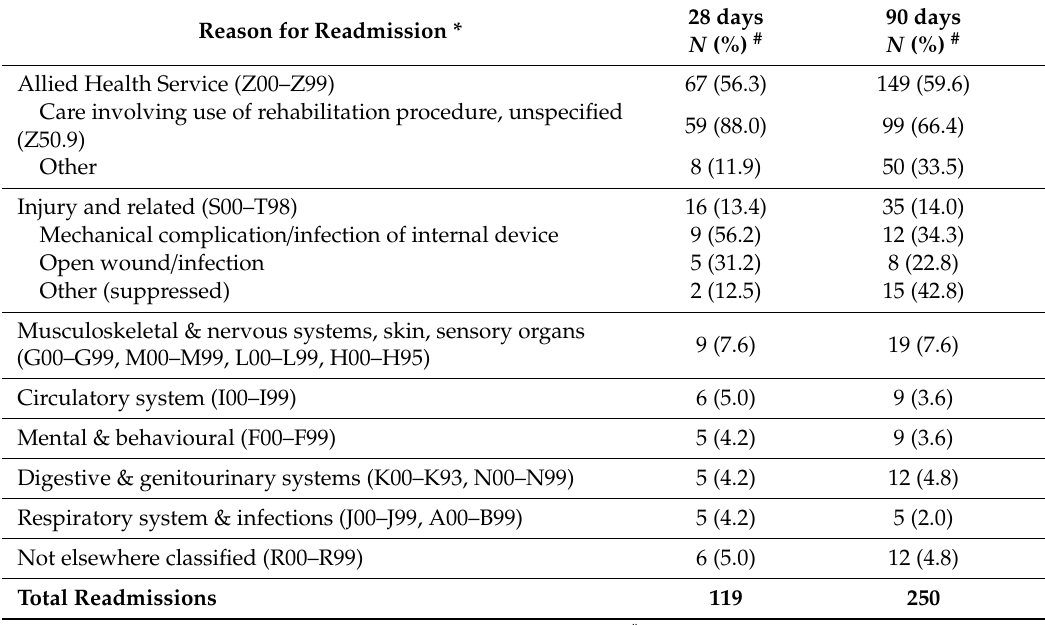
Table 2. Readmissions within 28 and 90